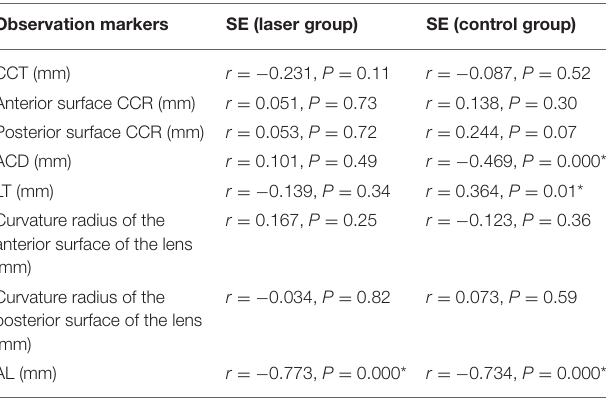
TABLE 4 | Correlations between refractive status and eye biology in the laser and control groups. Observation markers